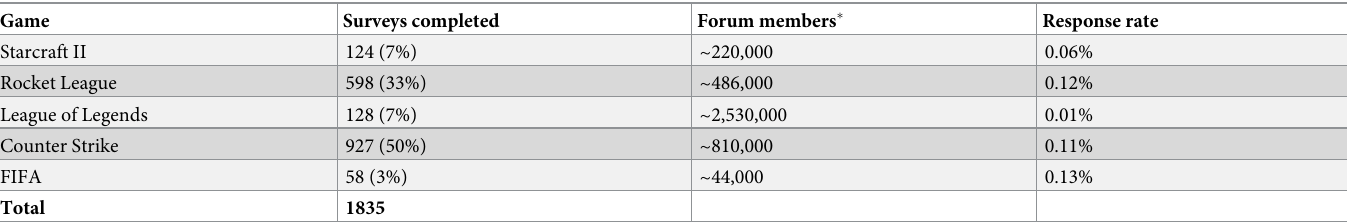
Table 12. Sample distribution.